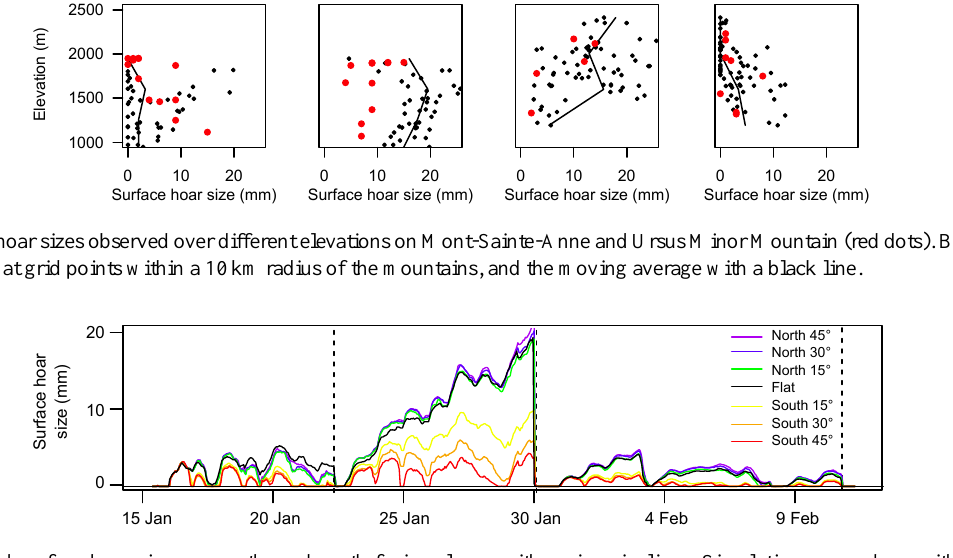
Figure 9. Modelled surface hoar sizes on north- and south-facing slopes with various inclines. Simulations were done with SNOWPACK using forecasts from the High-Resolution Deterministic Prediction System at 92 grid points at treeline elevations (1800 to 2200m) in Glacier National Park. The median crystal sizes for each slope are